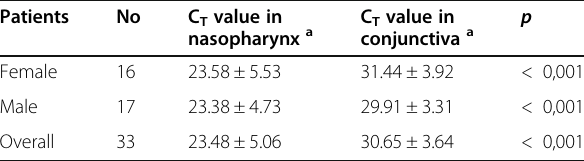
Table 3 The cycle threshold (C T ) values from patients with positive PCR test in conjunctival sac swab Patients